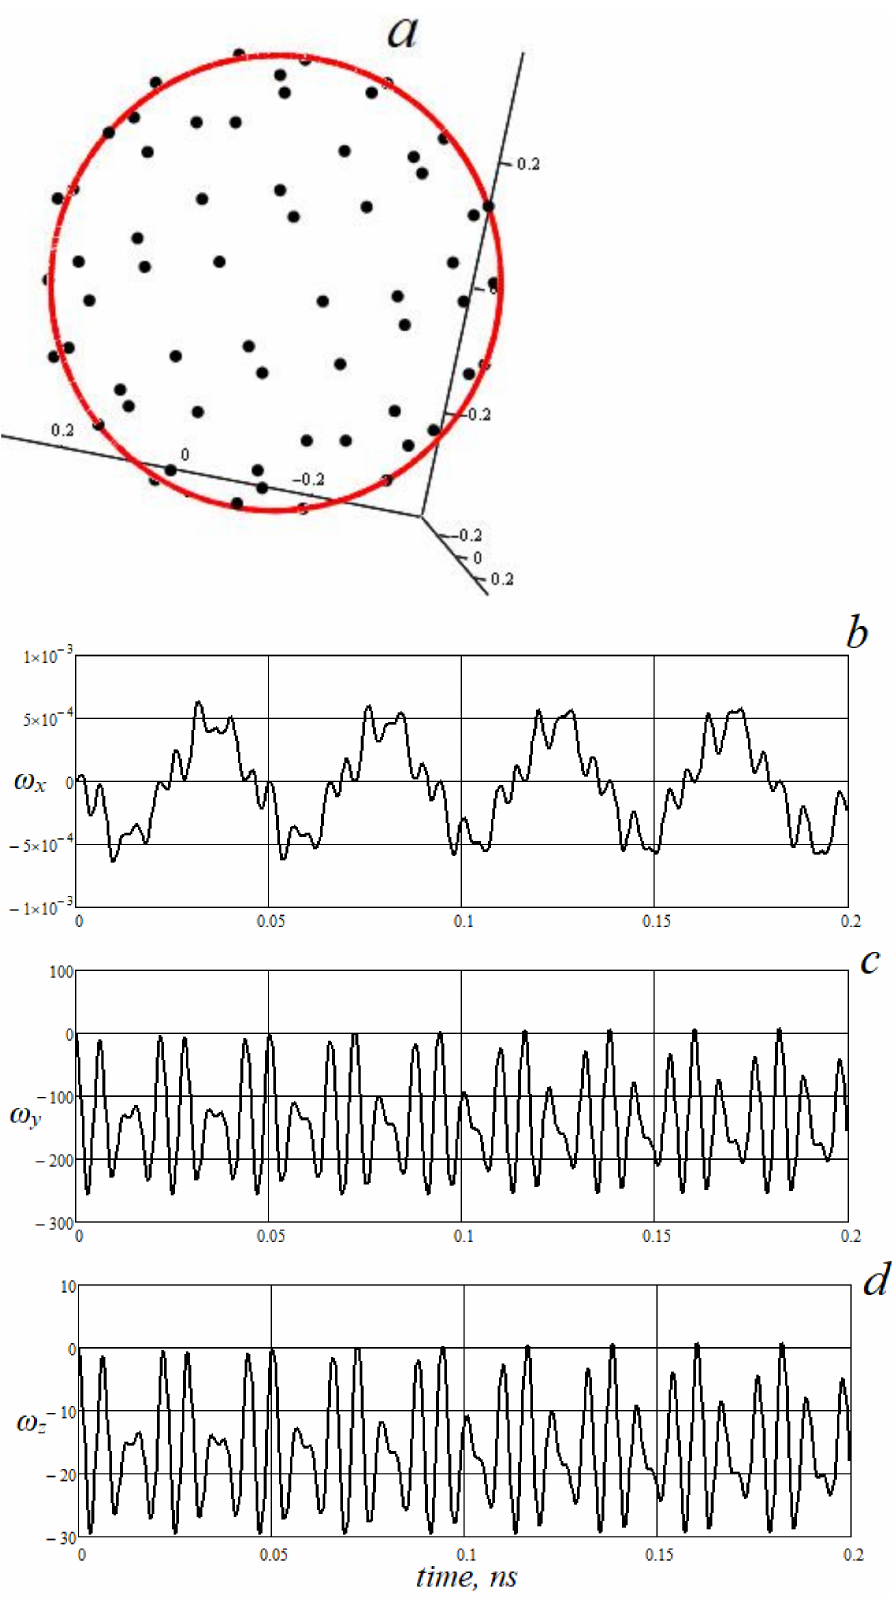
Figure 2. ( a ) Fullerene point trajectory; ( b ) x -projection of fullerene rotation frequency; ( c ) y -projection of fullerene rotation frequency; ( d ) z -projection of fullerene rotation